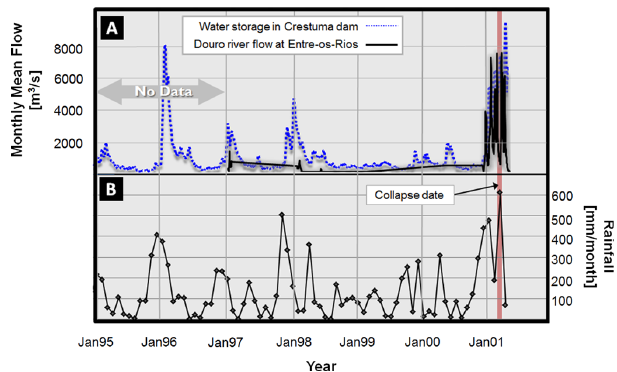
Fig. 10. (A) Monthly mean flow at Hintze Ribeiro bridge estimated based on the nearest dams water discharge and water storage in the Crestuma dam (nearest downstream dam). No data (river flow and discharges for the dams) were available for the period 1995–1997, for that reason, data related to the water storage in the Crestuma dam (nearest downstream dam) were used to infer the flow during this time interval. (B) Monthly rainfall at Entre-os-Rios weather station; (Rainfall and Flow Data source: national hydric resources informa- tion system – http://snirh.pt) from January 1995 to March